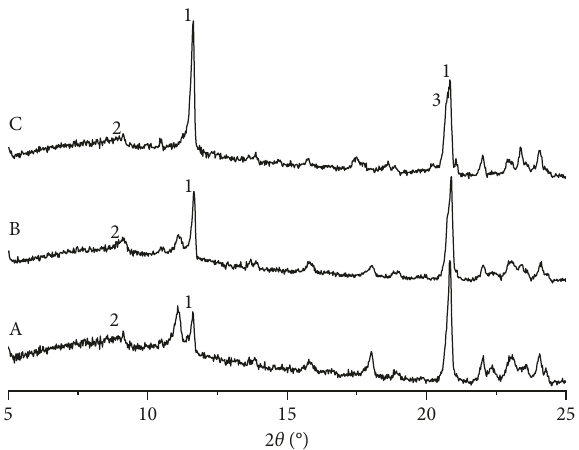
Figure 11: XRD results of corroded concrete (150 days). 1: Gypsum; 2: AFT; 3: quartz.